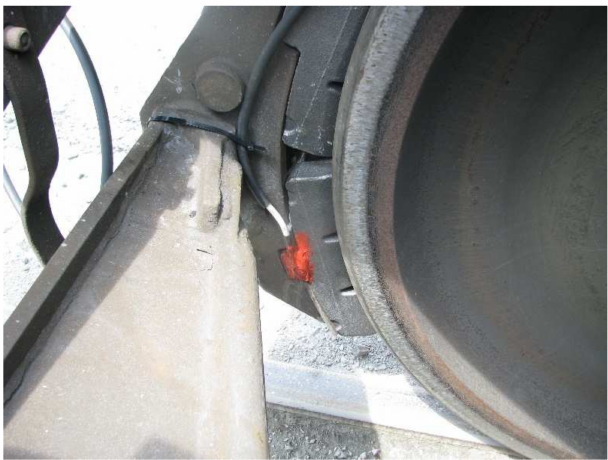
Figure 2. Brake block with temperature